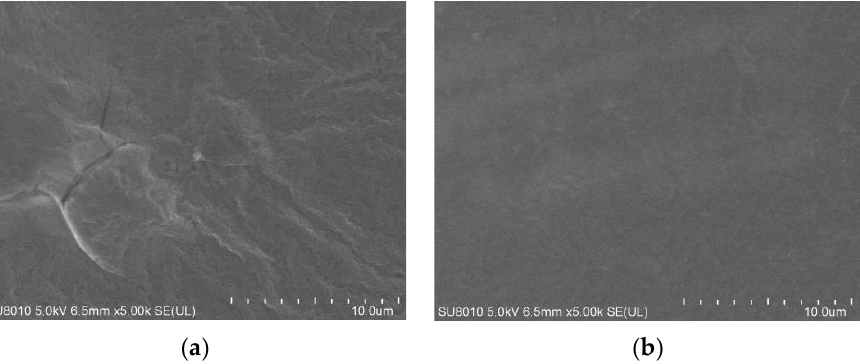
Figure 7. Scanning electron microscope images of the ACP−treated film and control. ( a ) Untreated soy protein film. ( b ) Soy protein film treated by ACP at 30 kV for 3 min. Untreated soy protein film was considered as the control. The amount of soy protein was 10% and glycerol was 2.8%.